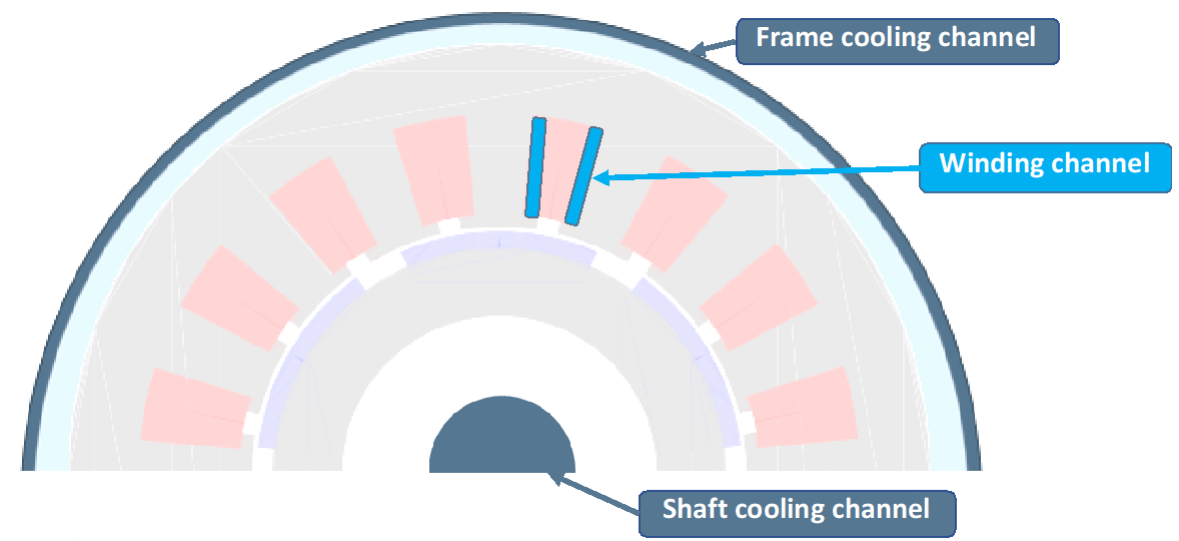
Figure 9. Cross-section of the electric actuator with two different cooling devices (base cooling (grey color) and slot internal cooling (blue color)).